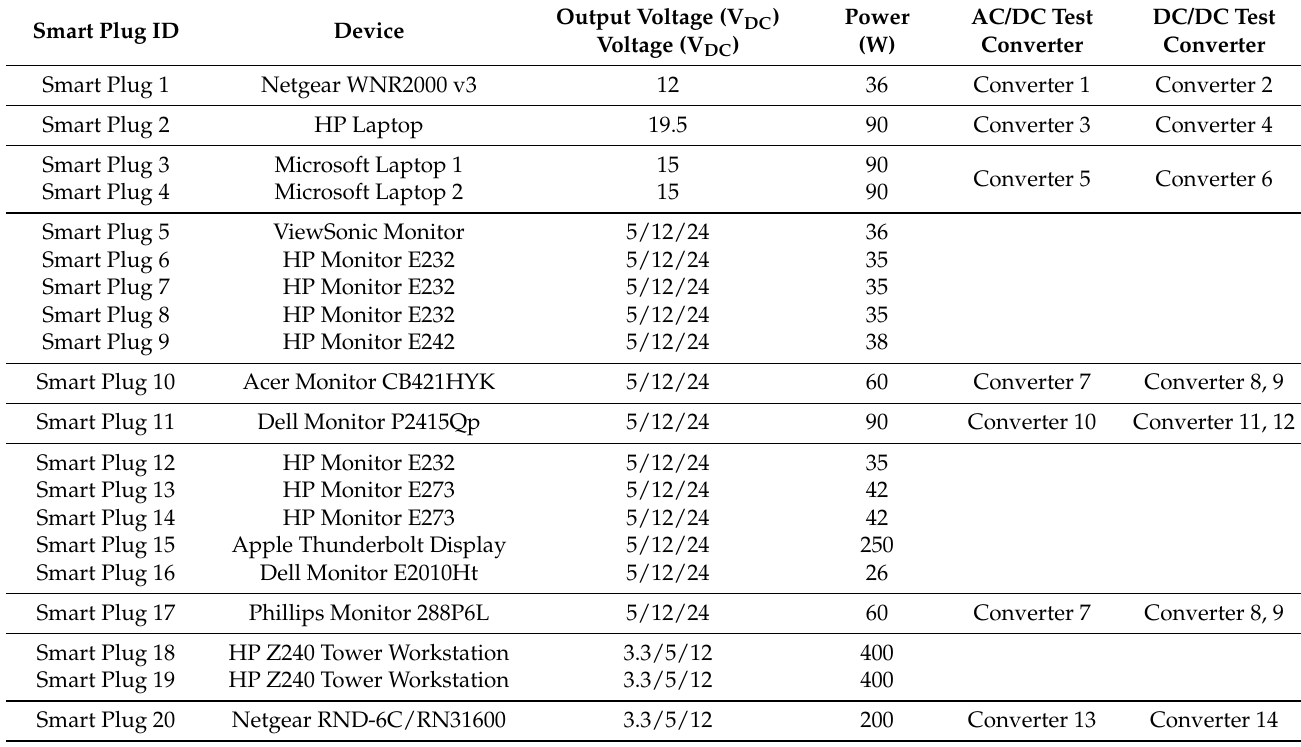
Figure 1. Grouped appliances’ operational power range when on. Data were collected for approximately 2 months at 1 Hz resolution. Frequencies are represented by boxplots with 95% confidence interval whiskers, with the boxes represent the interquartile range between the 25th and 75th percentile, and the orange lines represent the medians. Data outside the confidence interval are represented by the circles. Table 3 provides the whisker and median values. Table 2. Appliances and their respective AC/DC and DC/DC test